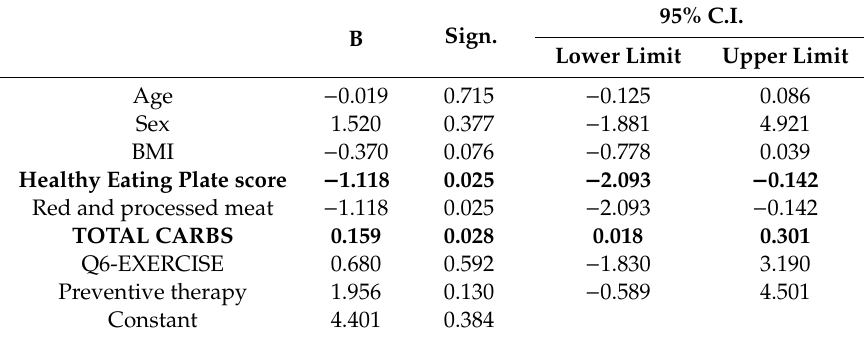
Table 5. Logistic regression of MMD changes on age, sex, BMI, TOTAL CARB intake, red and processed meat intake, and healthy plates score T0–T12 variations, ongoing preventive therapy, and physical activity. 95% C.I. B Sign. Lower Limit Upper Limit Age − 0.019 0.715 − 0.125 0.086 Sex 1.520 0.377 − 1.881 4.921 BMI − 0.370 0.076 − 0.778 0.039 Healthy Eating Plate score − 1.118 0.025 − 2.093 − 0.142 Red and processed meat − 1.118 0.025 − 2.093 − 0.142 TOTAL CARBS 0.159 0.028 0.018 0.301 Q6-EXERCISE 0.680 0.592 − 1.830 3.190 Preventive therapy 1.956 0.130 − 0.589 4.501 Constant 4.401